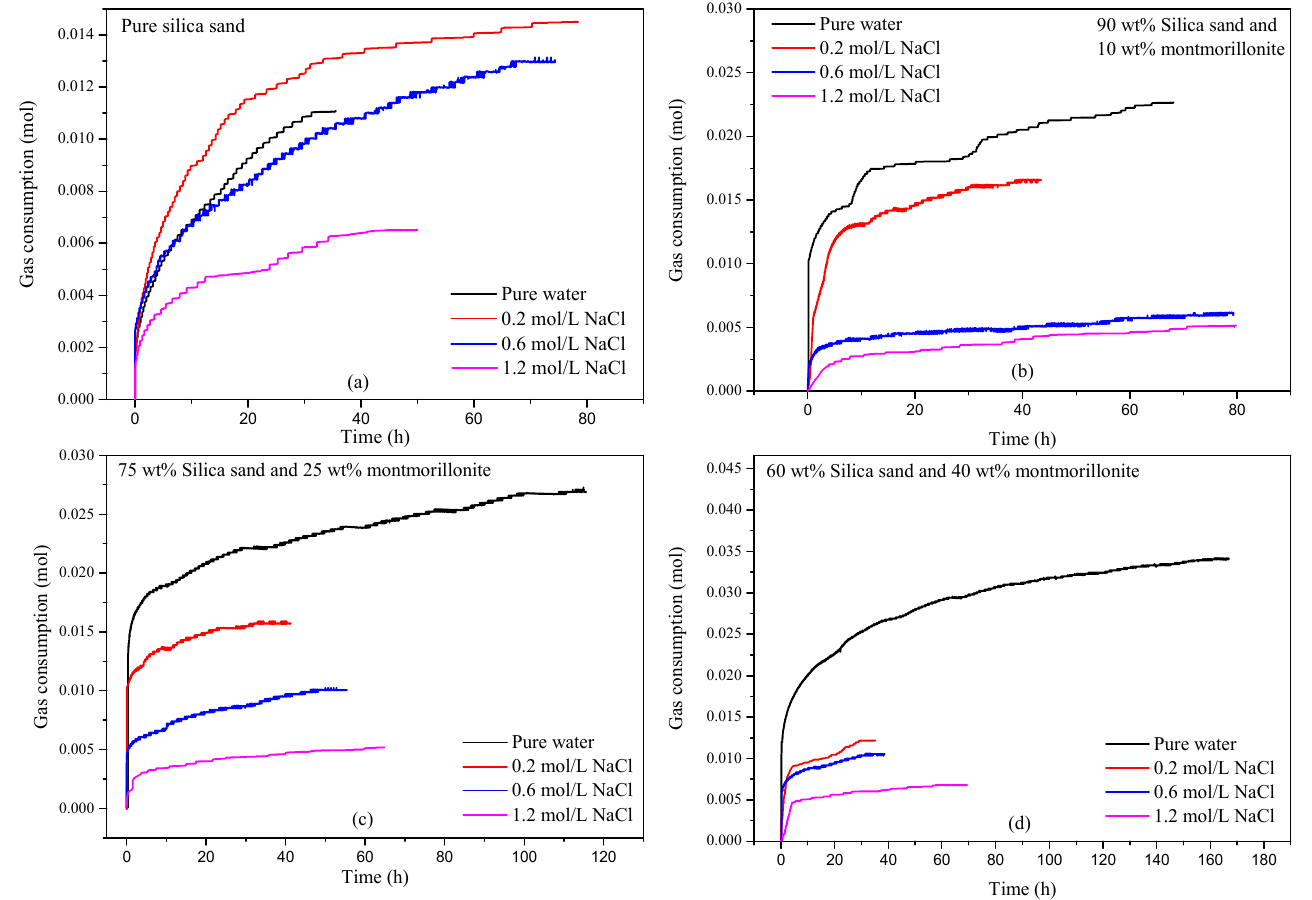
Figure 6. Comparison of methane consumption during hydrate formation in different experiments. ( a ) Pure silica sand. ( b )90 wt% silica sand and 10 wt % montmorillonite. ( c ) 75 wt% silica sand and 25 wt % montmorillonite. ( d ) 60 wt% silica sand and 40 wt % montmorillonite.